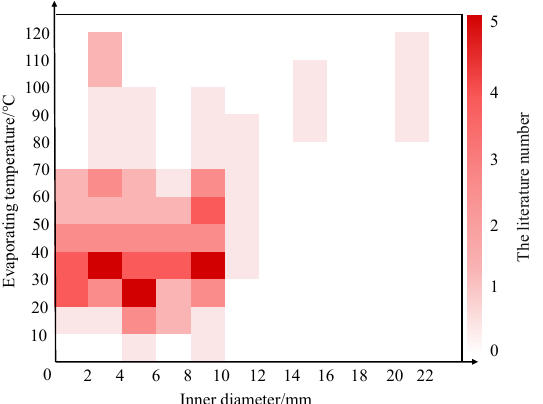
( b ) Figure 20. Heat exchange process between working fluid and heat source in evaporator of the ORC: ( a ) pure fluid; and ( b ) zeotropic mixture. In summary, the aforesaid research demonstrates that different working fluids, evap- oration temperatures, and pipe diameters have a great impact on flow boiling heat trans- fer characteristics. Zeotropic mixtures can improve ORC performance, but the poor heat transfer characteristics limit their application. However, little research has been conducted on heat transfer characteristics at the temperature range that is suitable for ORC evapora- tion. Figure 21 shows the distribution of experimental conditions of the flow boiling heat transfer characteristics of the ORC − recommended working fluid from Bao et al. [91]. The testing conditions of the ORC − recommended working fluids are mainly concentrated on the small pipe diameter and low evaporating temperature range. The research on large